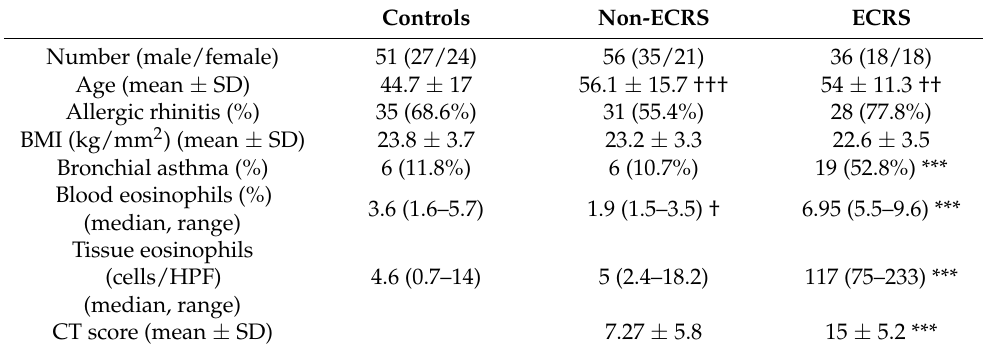
Table 1. Background and baseline characteristics of the study population.